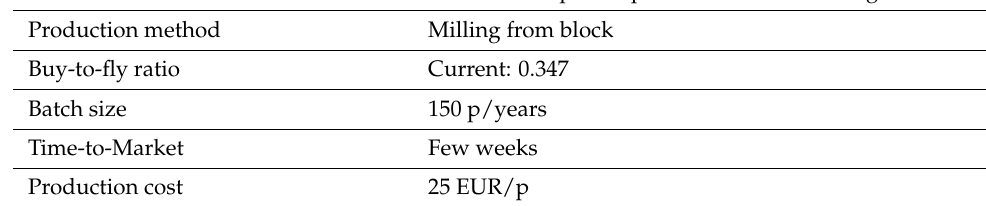
Table 7. Design requirements for the analysed product.